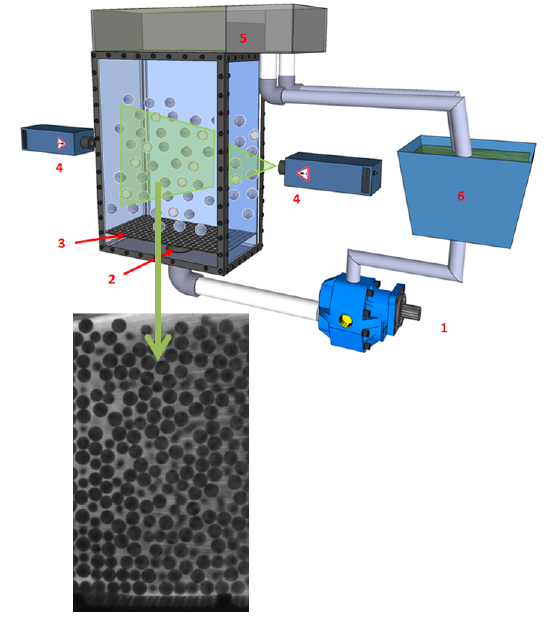
Figure 2. Sequences of transient fluidized area expansion ( d = 3 mm , D = 20 mm , H 0 = 125 mm ) at successive time steps t = 1 s , t = 2 s , t = 5 s , and t = 10 s , with, from top to bottom, injection flow rates Q and transient duration T 0 equal to Q = 117 . 5 cm 3 . s − 1 and T 0 = 1 . 80 s , Q = 68 . 1 cm 3 . s − 1 and = 2 . 72 s , Q = 50 . 4 cm 3 . s − 1 and T = 4 . 65 s , Q = 44 . 6 cm 3 . s − 1 T 0 0 and T 0 = 8 . 30 s